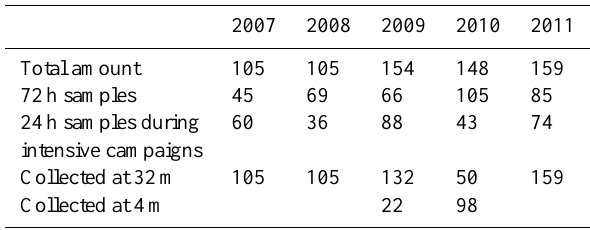
Table 1. HV filters collected at the CVAO from 2007 to